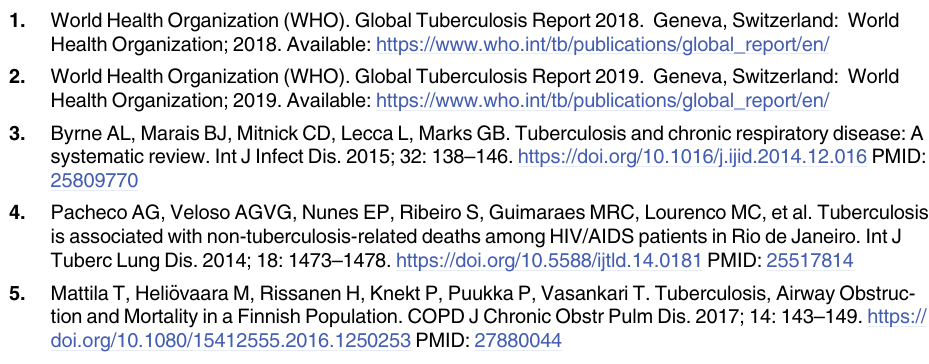
S2 Table. MEDLINE database search for systematic review of tuberculosis and the risk of cardiovascular disease and related mortality.